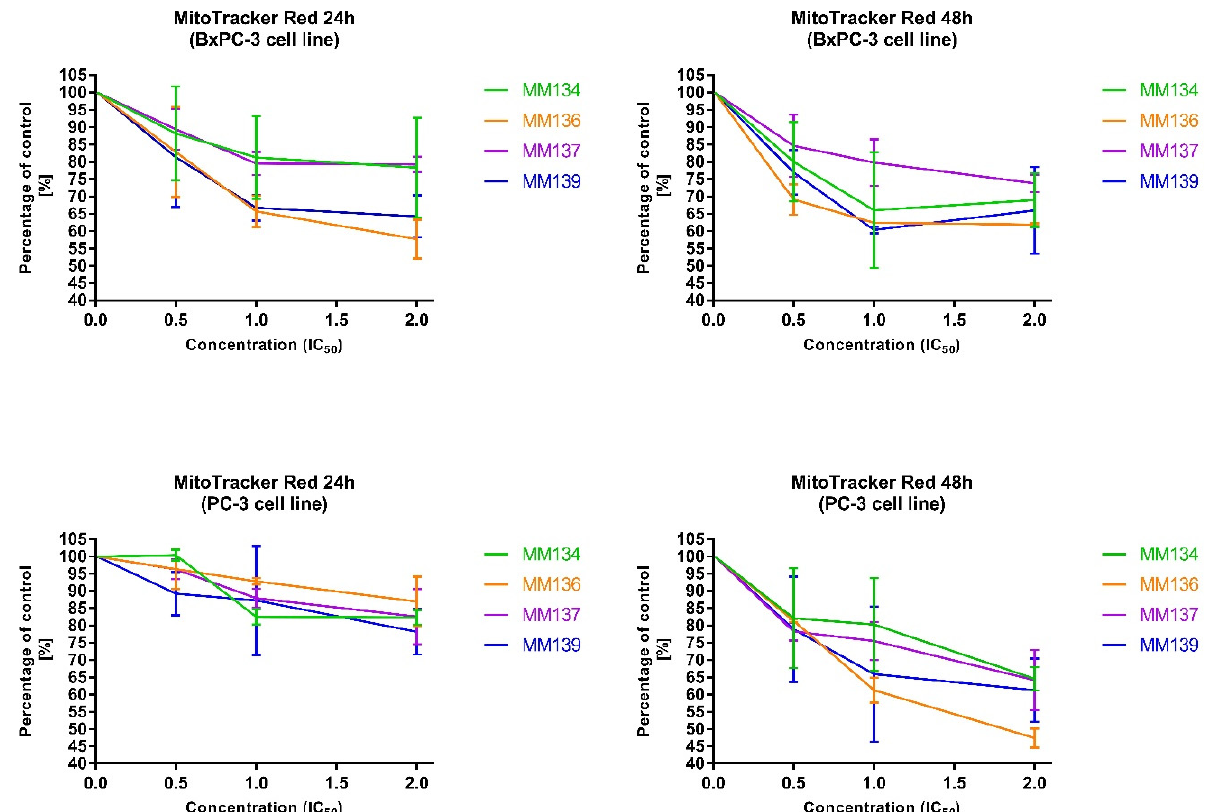
Figure 11. Changes in the mitochondria membrane potential (MMP) after 24 h and 48 h incubation with MM-compounds in all tested cancer cell lines; ±SD value.